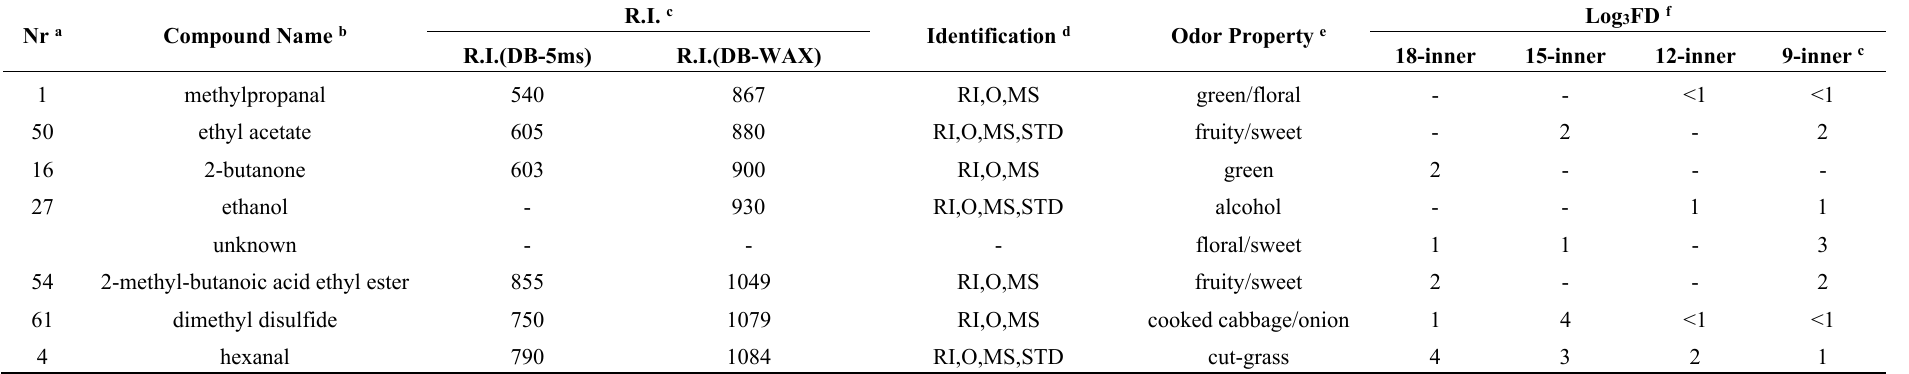
Table 3. Aroma-active compounds in Jinhua ham by